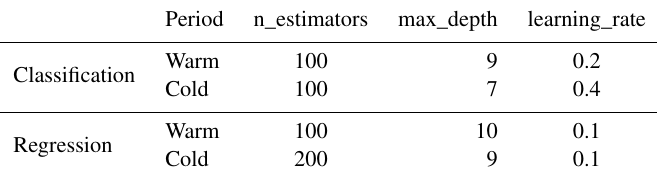
Table C2. The optimal parameters of GBDT model training.